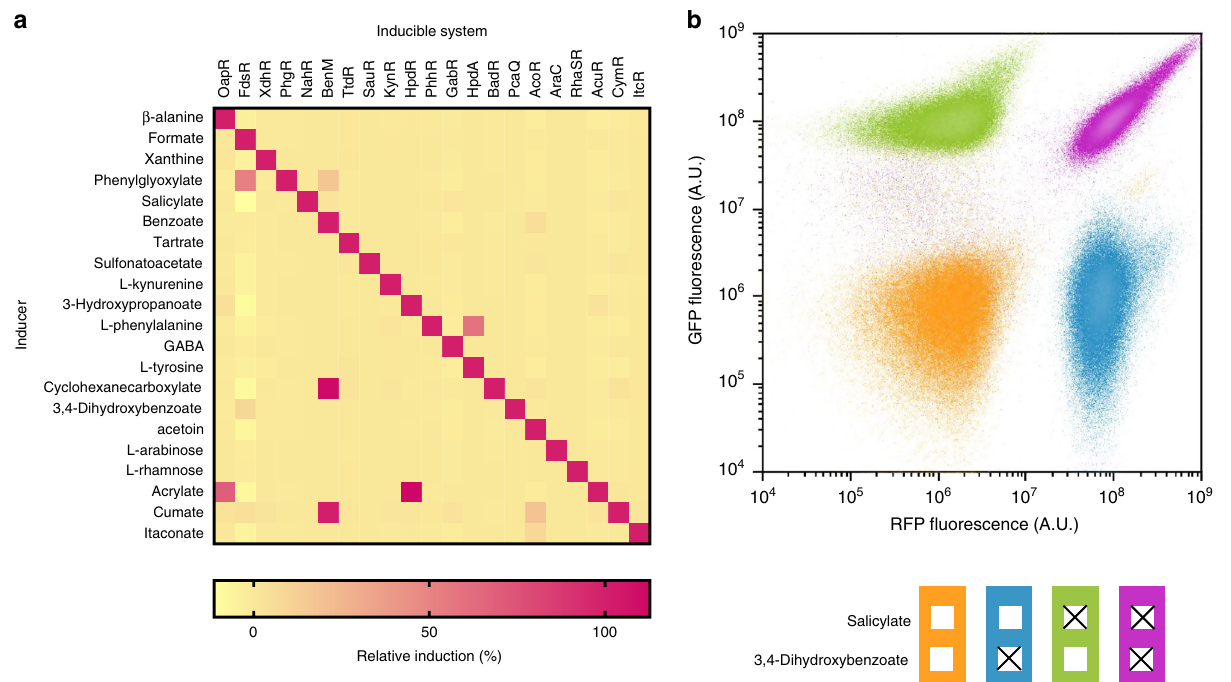
Fig. 6 Orthogonality of inducible systems. a Cross-reactivity of a set of 21 inducible systems and their corresponding primary inducers. The heat map illustrates induction of reporter gene expression in the presence of the metabolite (in %) relative to the induction mediated by the corresponding primary effector. Measurements were taken 6 h after supplementation with inducer at a fi nal concentration of 5 mM. Data are mean, n = 4. Source data are provided as a Source Data fi le. b Fluorescence output of individual cells of C. necator carrying pEH263 measured by fl ow cytometry. The vector pEH263 contains the 3,4-dihydroxybenzoate- and salicylate-inducible systems controlling expression of rfp and egfp , respectively. Fluorescence was determined in the absence of inducer (orange), in the presence of 3,4-dihydroxybenzoate (blue), salicylate (green), and both 3,4-dihydroxybenzoate and salicylate (purple). Effector concentrations correspond to their respective K m ’ s and fl uorescence was measured 2 h after inducer